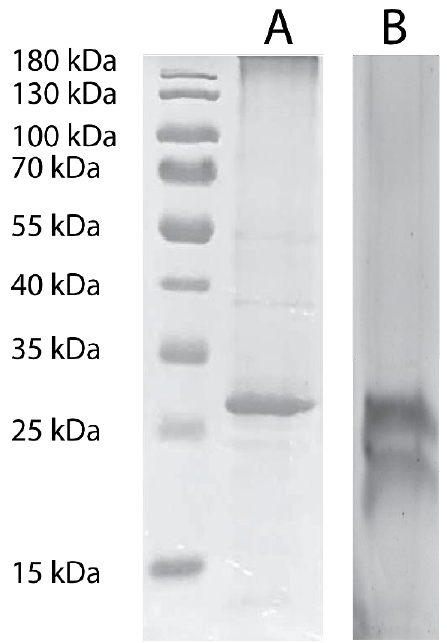
Figure 2. SDS-PAGE of purified hAQP2 as produced from 1.5 L cultures in ( A ) LT-SEVIN and ( B ) SEVIN growth protocols. The marker used was a Promega pre-stained protein ladder. Purified protein was concentrated to 2 mg/mL and 5 µL ( A ) or 10 µL ( B ) was incubated for 10 min at 65 °C with 5X SDS-PAGE loading dye (10% (w/v) SDS, 500 mM DTT, 50% (w/v) glycerol, 250 mM Tris-HCL, pH 6.8, and 0.5% (w/v) bromophenol blue dye). Samples were run at 110 V for 90 min, and bands were visualized with Coomassie Blue G-250 (Bio-Rad).